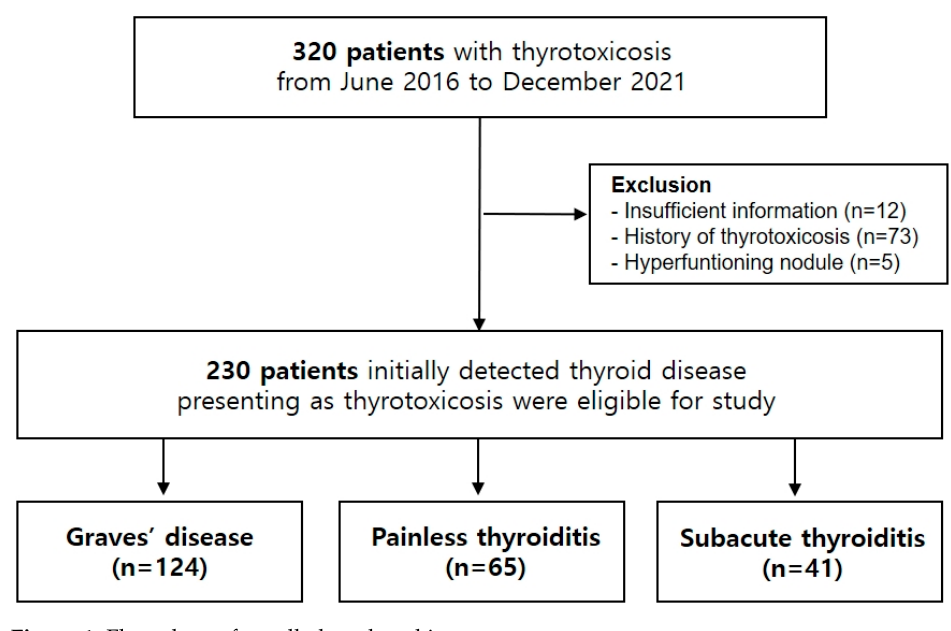
Figure 1. Flow chart of enrolled study subjects. Table 1. Baseline characteristics of the study cohort.